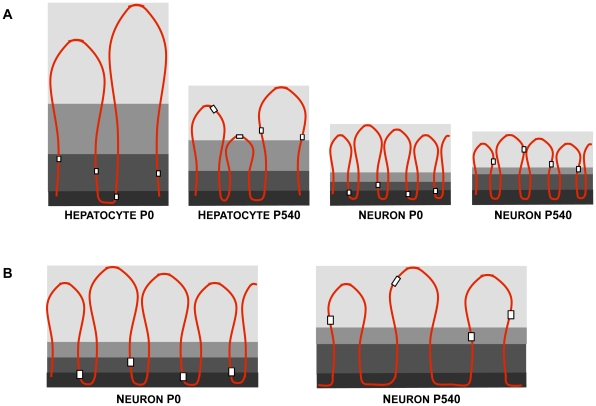
Two possible models for explaining the observed changes in the NHOS as a function of age.A) in newborn rat hepatocytes (P0) with high proliferating potential, the DNA loops are large and heterogeneous in size and yet the target-gene sequences (white squares) are located rather close to the NM (dark grey), while in the aged hepatocytes (P540) DNA loops become shorter, more homogeneous in size as further potential MARs become actualized substituting some previous MARs bound to the NM and so genes become rather distal to the NM, correlating with the significant loss of proliferating potential in aged hepatocytes (hepatocyte-related figures based on our previous data from reference 20). In newborn (P0) post-mitotic neurons the DNA loops are already quite homogeneous and significantly shorter than in aged hepatocytes. Yet in the aged (P540) neurons most of the former MARs bound to the NM have been substituted by other MARs located on average far from any gene, resulting in a significant change in the relative position to the NM of most genes without affecting the average DNA loop size. B) In this case larger stretches of DNA adjacent to the original MARs in P0 neurons, become attached to the NM as a function of time, leading to a reduction in the actual number of DNA loops without significantly affecting their average size but causing a displacement of most genes towards regions distal to the NM. The evidence that a larger fraction of DNA directly interacts with the NM in P540 neurons when compared with P0 neurons (Fig. 3) and that quantitative changes in the NM composition occur with age (Fig. 6) is consistent with the model in B for the case of neurons.